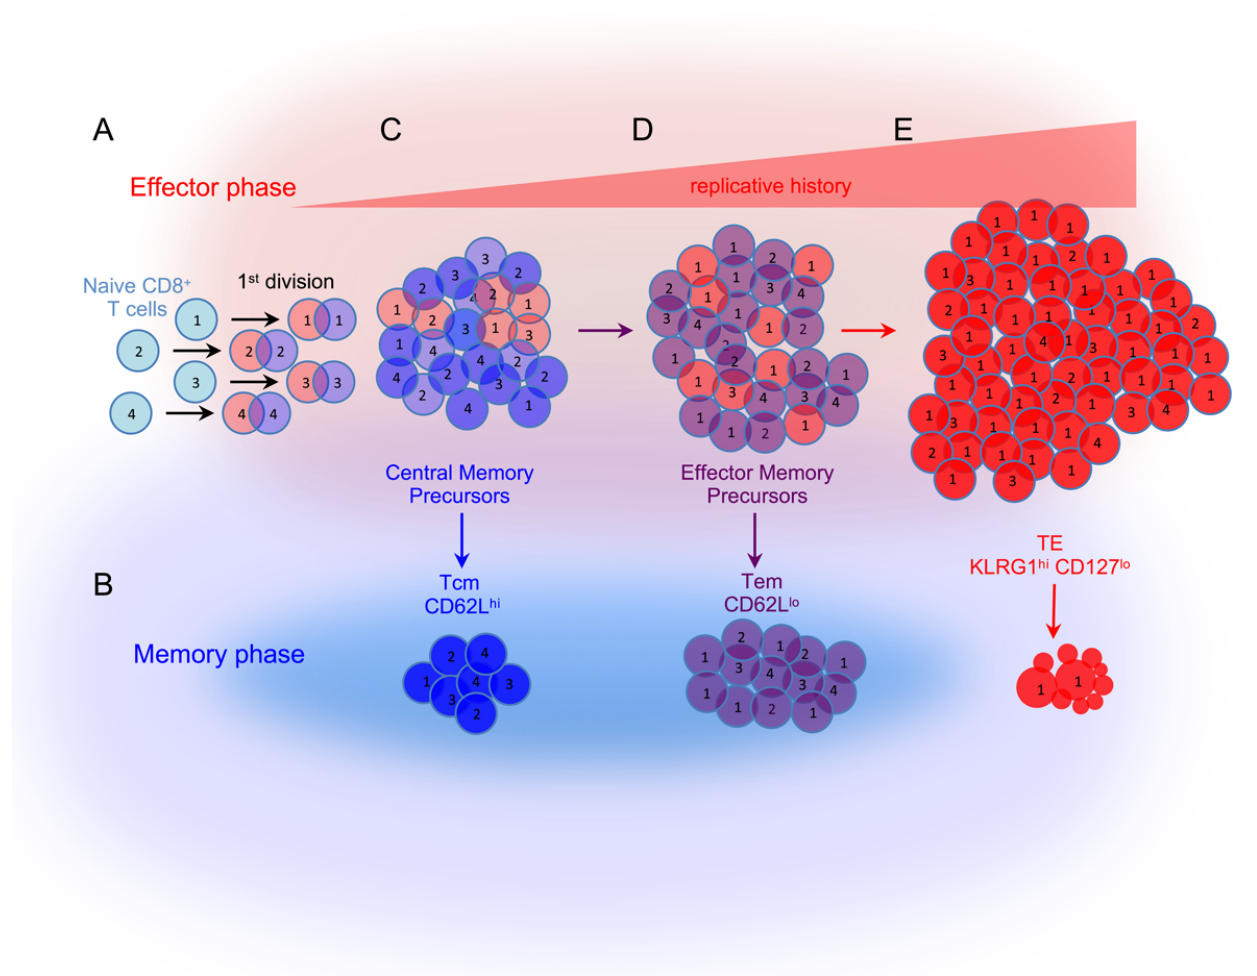
Figure 2. The descent of individual naïve CD8 T cells into effector and memory CD8 T-cell progeny on the basis of lineage tracing and single-cell transfer studies. ( A ) Individual naïve CD8 T cells are recruited into the response and undergo geometric accumulation resulting in distinct CD8 T-cell families (numbers) derived from individual naïve cells. ( B ) Each naïve cell has the potential to differentiate into progeny that exhibit central memory T (Tcm) (blue), effector memory T (Tem) (purple), or terminal effector (TE) (red) CD8 T-cell phenotypes. ( C ) Central memory precursors (light blue) are composed of diverse families that divide slowly, ( D ) some of which give rise to faster-dividing Tem precursors (purple). ( E ) TE CD8 T cells comprise relatively few CD8 T-cell families that have accumulated dramatically and most